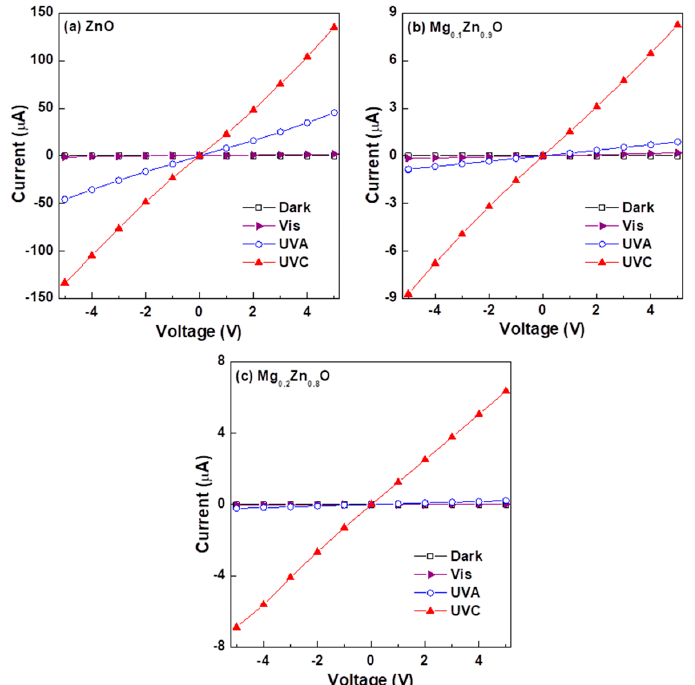
Figure 8. Current–voltage ( I – V ) characteristics of Mg x Zn 1 − x O photodetectors showing dark current and photoilluminated currents under irradiation with visible UVA and UVC light. The photodetectors were based on ( a ) ZnO, ( b ) Mg 0.1 Zn 0.9 O, and ( c ) Mg 0.2 Zn 0.8 O semiconductor thin films.